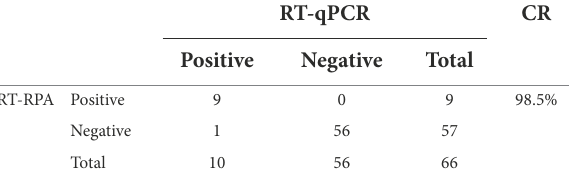
TABLE 4 Detection of MHV in samples using the RT-RPA and real-time RT-PCR methods a .